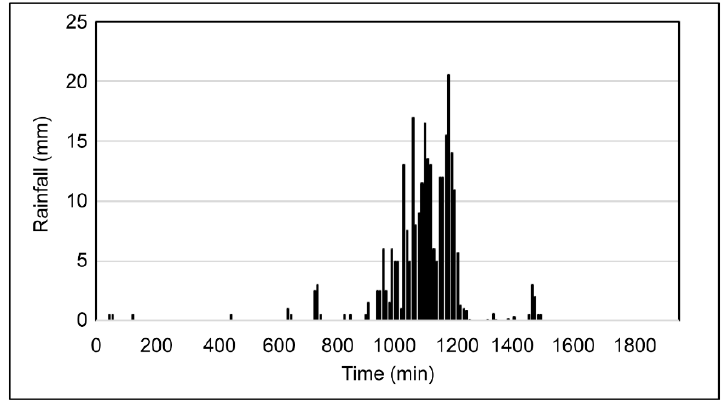
Figure 8. Hyetograph at Seoul AWS (20~21 September 2010).